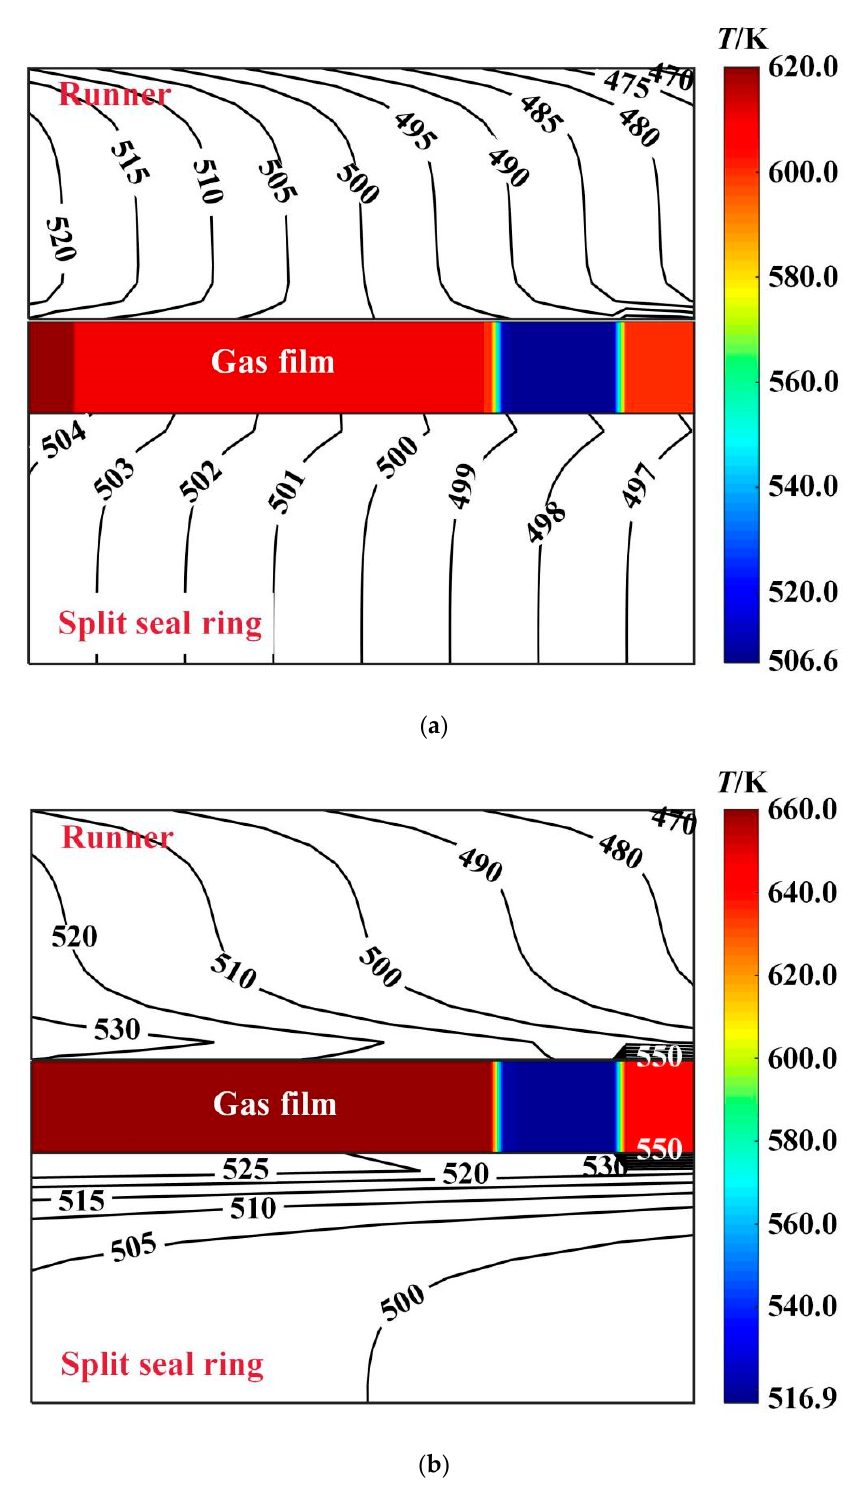
Figure 17. Influence of rotation speed on the maximum temperature of gas film. ( p i = 0.2 MPa, ω = 3.0 × 10 4 r/min, T in = 580 K, T out = 420 K). ( a ) β = 6 × 10 − 6 rad; ( b ) β = 0.